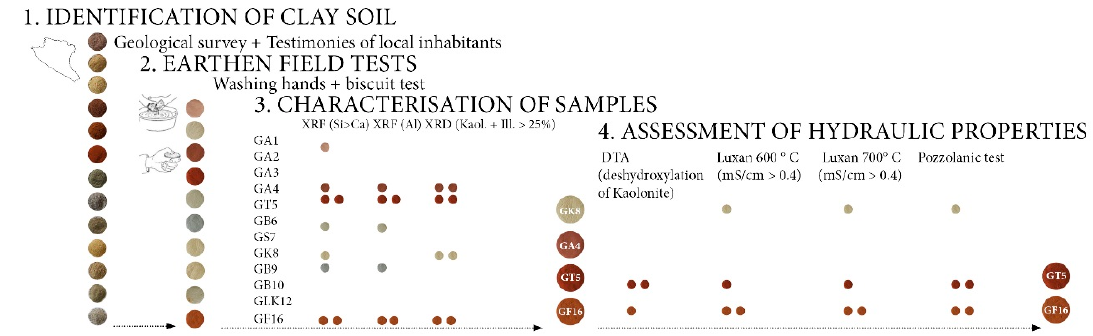
Figure 10. Overview of the analysis process.